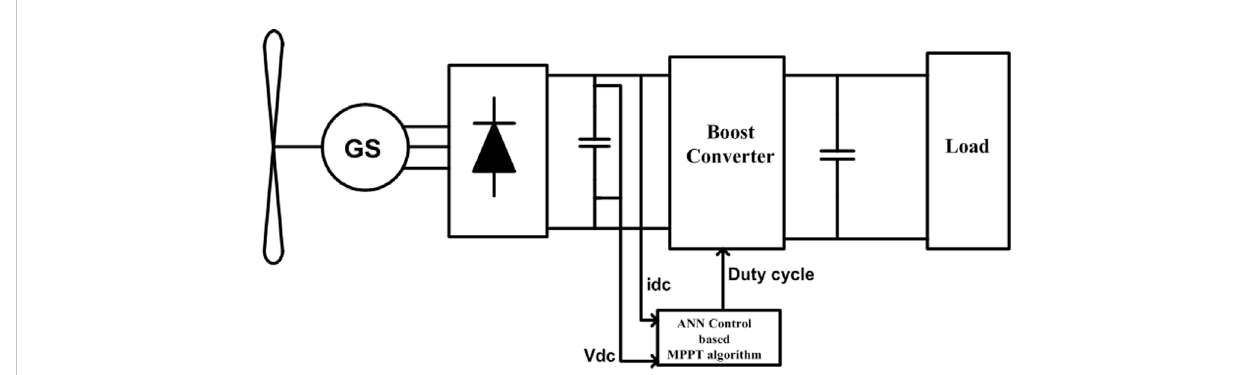
FIGURE 4 WECS con fi guration (Vas, 1999).